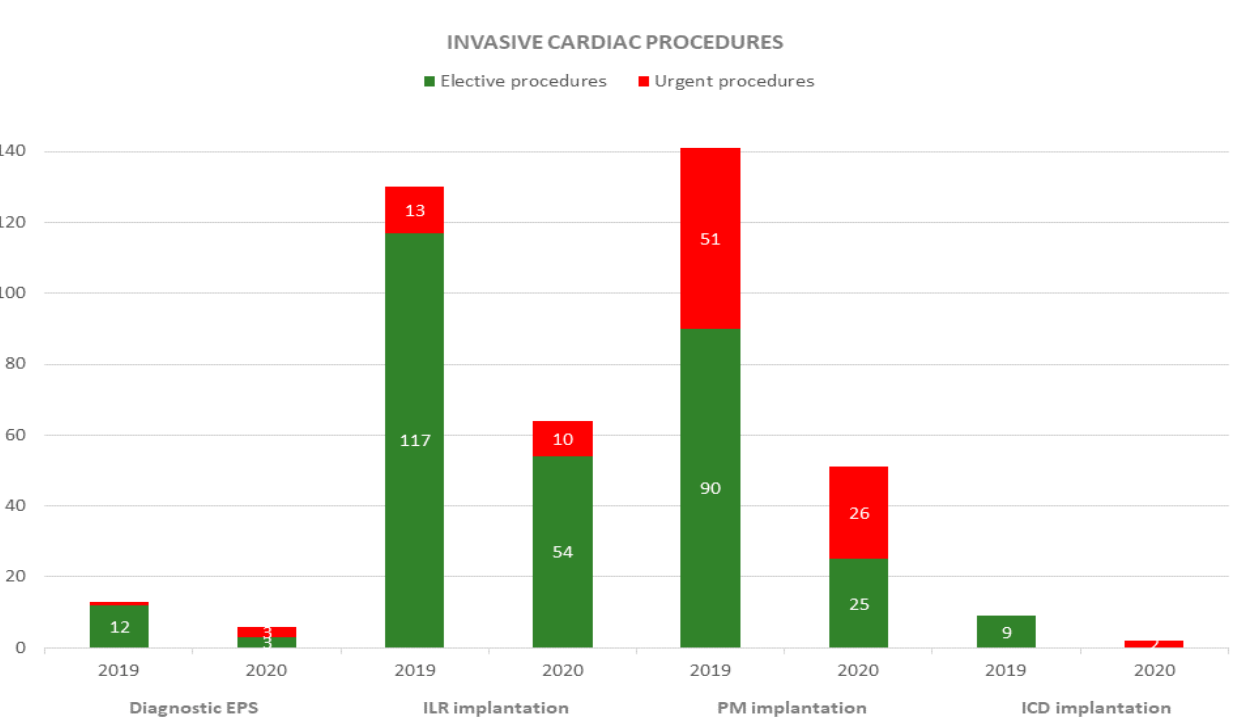
Figure 3 . Number and type (elective or urgent) of invasive cardiac procedures during 2019 and 2020 study periods.EPS: electrophysiological study; ILR: implantable loop recorder; PM: pacemaker; ICD: implantable cardioverted defibrillator.